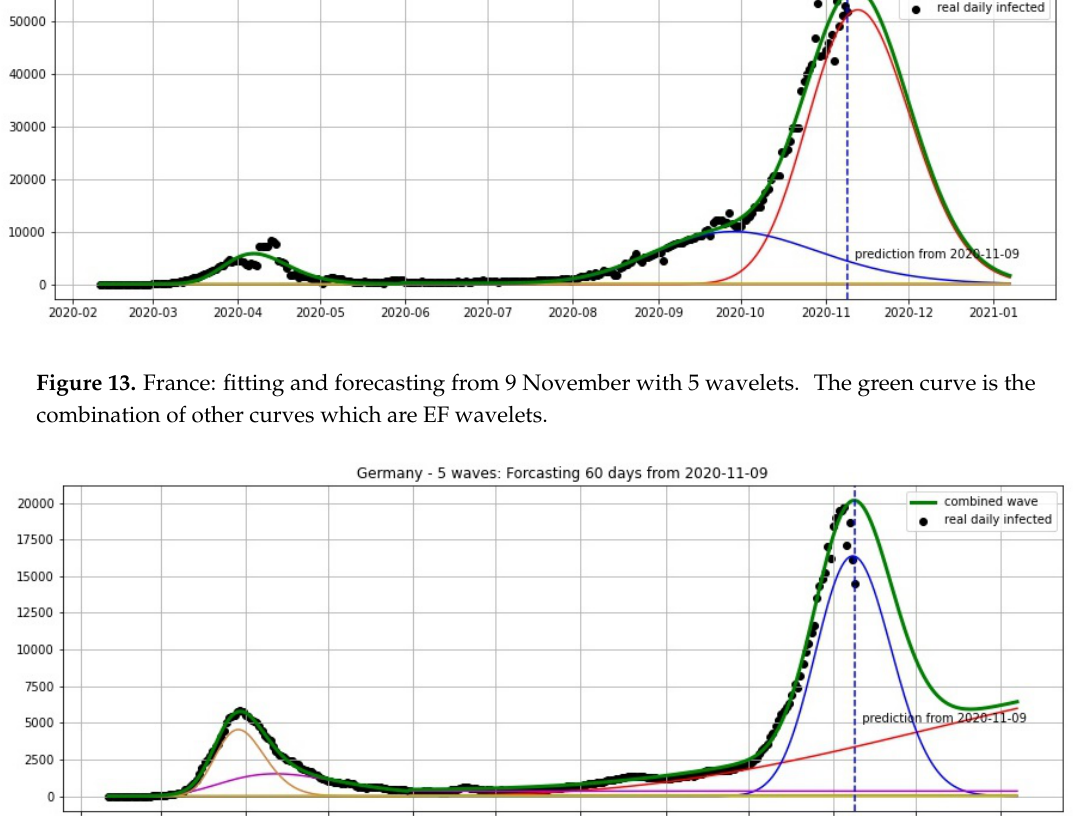
Figure 14. Germany: fitting and forecasting from 9 November with 5 wavelets. The green curve is the combination of other curves which are EF